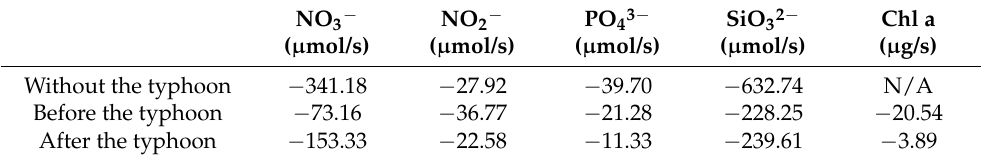
Table 2. Cross-shelf nutrient fluxes per unit area in OSW.